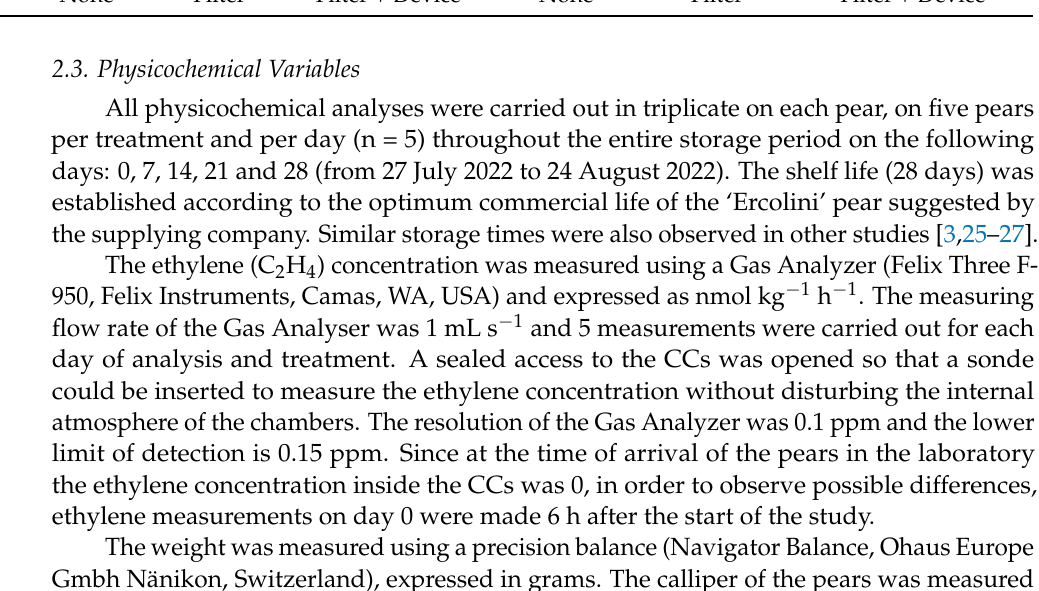
Table 2. Classification of the treatments applied according to storage temperature (°C), relative hu- midity (%) and the presence or absence of ethylene scavengers.